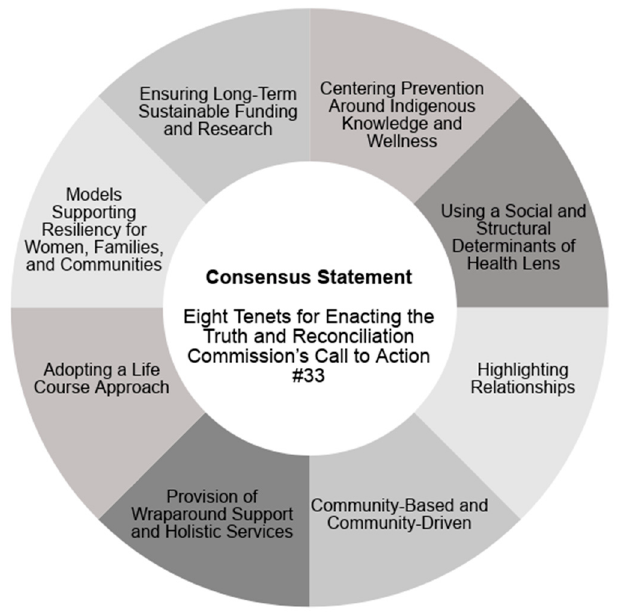
Figure 1. A graphic visualization of the Consensus Statement: Eight Tenets for Enacting the Truth and Reconciliation Commission’s Call to Action #33. The eight tenets are (1) Centering Prevention around Indigenous Knowledge and Wellness; (2) Using a Social and Structural Determinants of Health Lens; (3) Highlighting Relationships; (4) Community-Based and Community-Driven; (5) Provision of Wraparound Support and Holistic Services; (6) Adopting a Life Course Approach; (7) Models Supporting Resiliency for Women, Families, and Communities; and, (8) Ensuring Long-Term Sustainable Funding and Research.